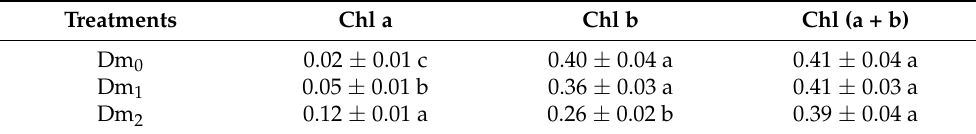
Table 4. The effects of different fertigation treatments (Dm 0 —standard nutrient solution, Dm 1 —raw leachate treatment, and Dm 2 —raw leachate blended with H 2 O 2 treatment) on pigment concentrations (expressed in mg g − 1 FW) in D. marginata plants at the end of the experiment. The results are expressed as means ± standard deviation ( n = 4). In each column, the same letters indicate non- significant differences ( p < 0.05).